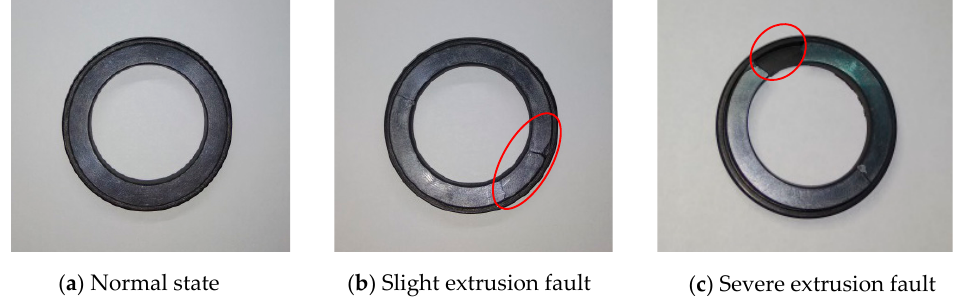
ff erent extrusion